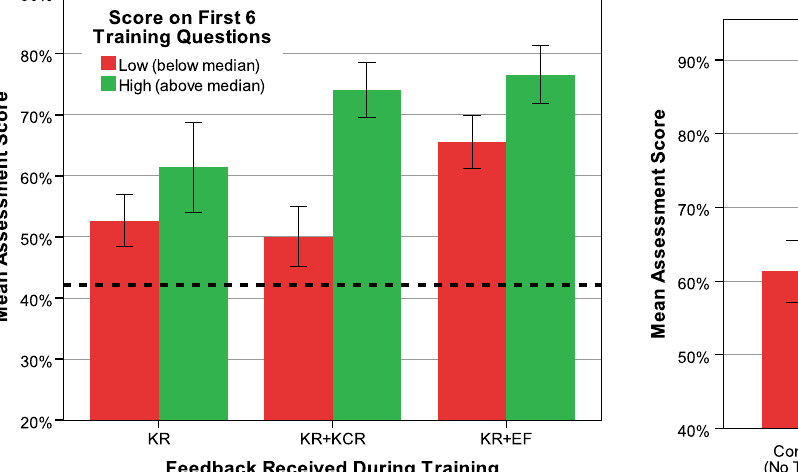
FIG. 6. Experiment 2 mean assessment scores for each